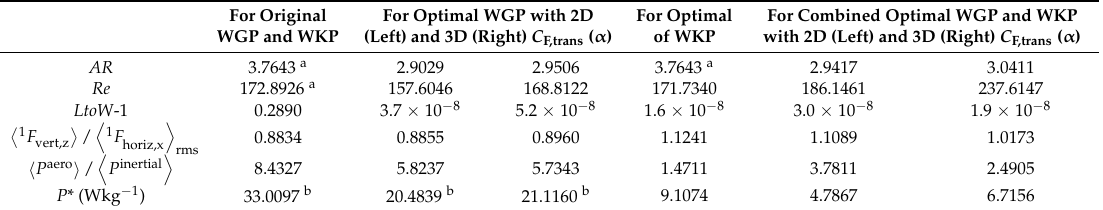
Table 4. The estimated values of hovering fruit fly and optimization results. For Original For Optimal WGP with 2D WGP and WKP (Left) and 3D (Right) C F,trans ( α )